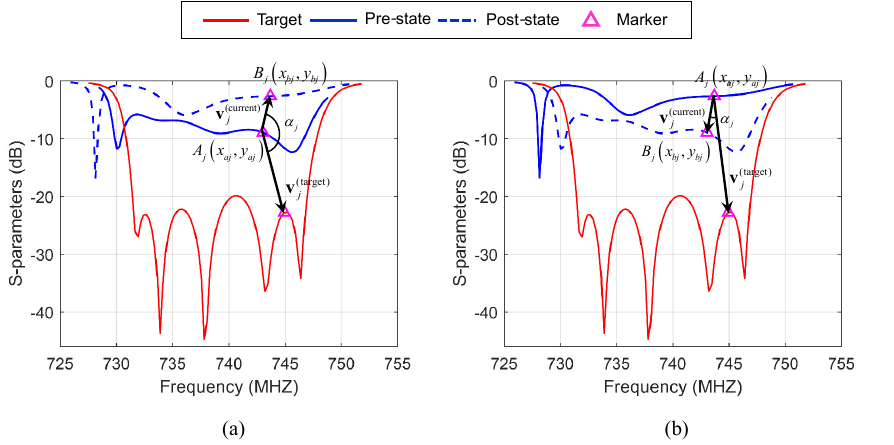
Figure 4. Formulate the change of S–parameter curves with vector fields: ( a ) The angle α j is obtuse denoting that the current change direction is moving away from the target. ( b ) The angle α j is acute denoting that the current change direction is approaching the